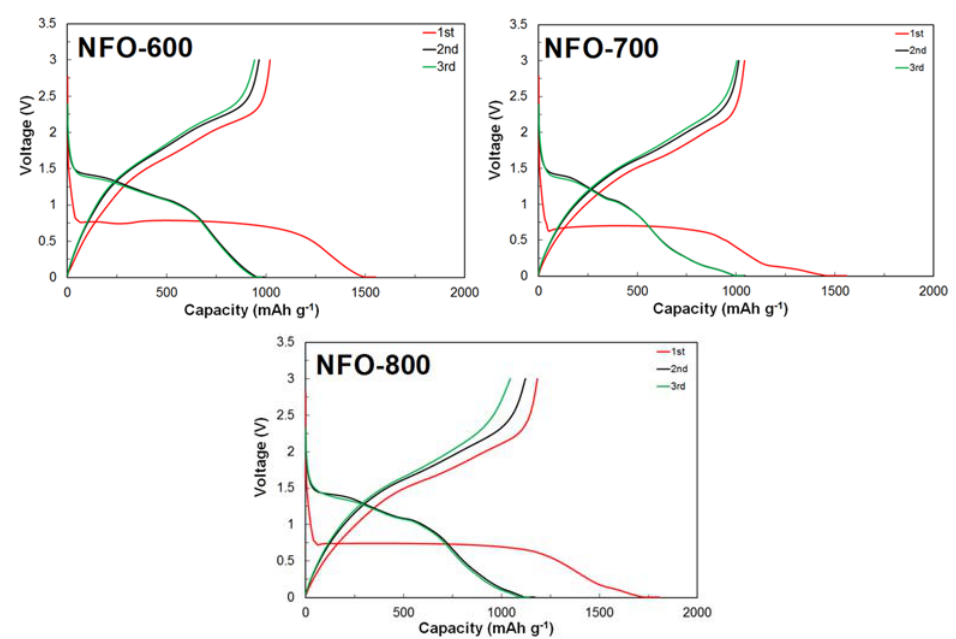
Figure 7. The initial charge-discharge profiles of the NiFe 2 O 4 electrode annealed at different temperatures.